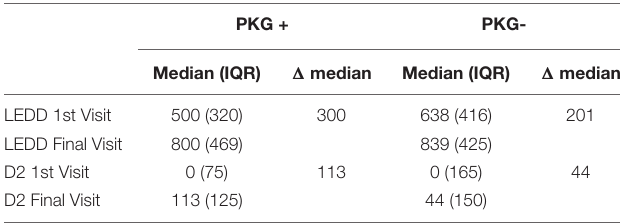
TABLE 4 | Changes in LEDD in PKG + and PKG-